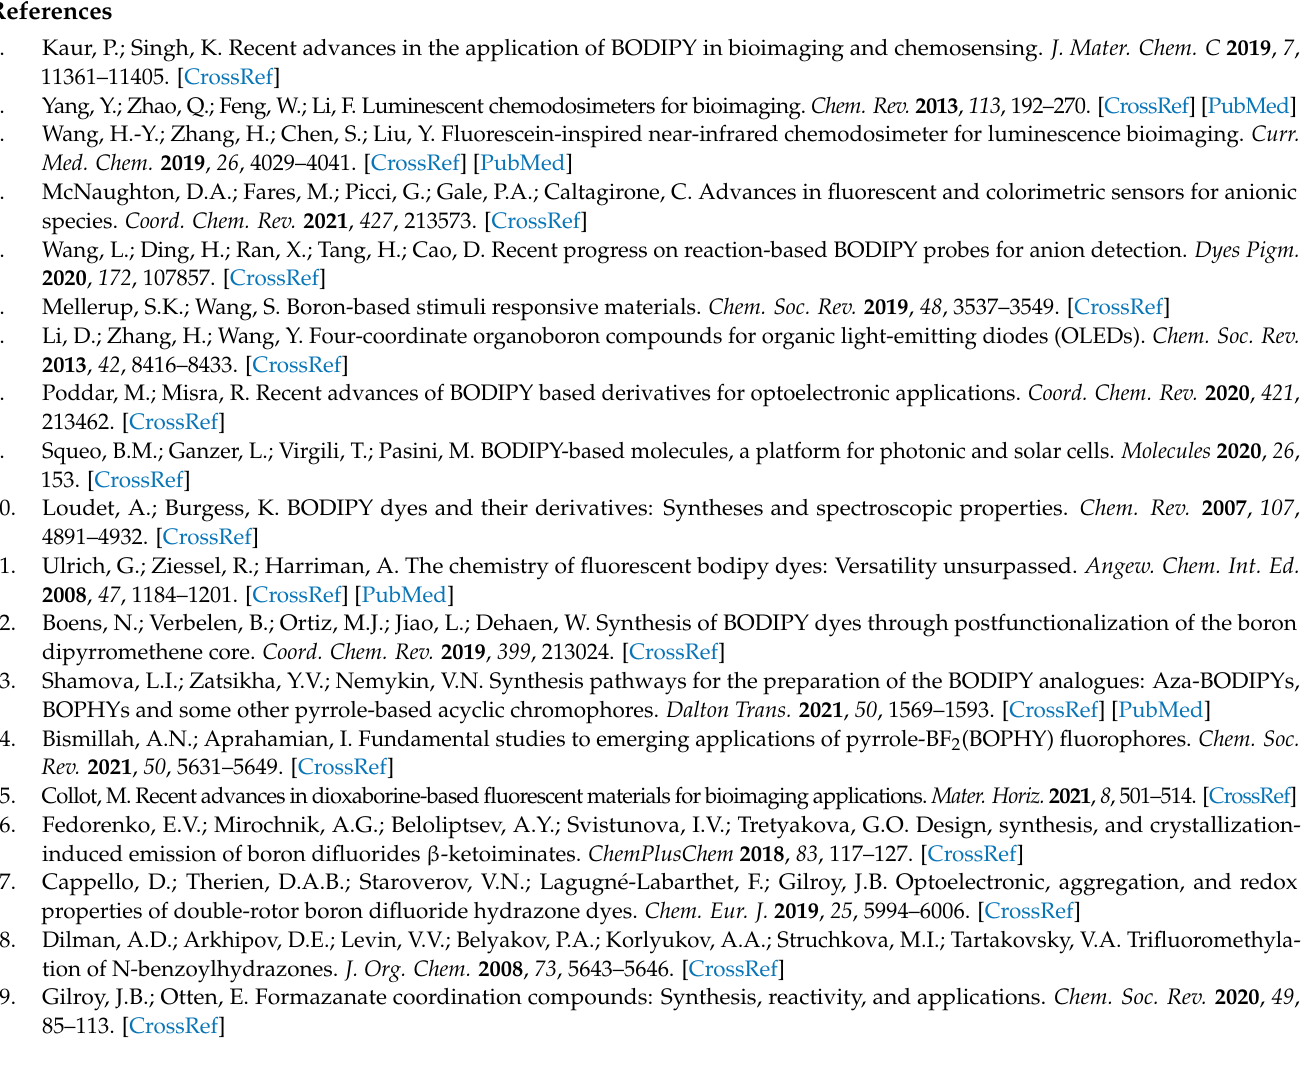
IR-spectrum of 17; Figure S2: 1 H NMR of 17; Figure S3: 13 C NMR of 17; Figure S4: HRMS of 17; Figure S5: IR-spectrum of 18; Figure S6: 1 H NMR of 18; Figure S7: 13 C NMR of 18; Figure S8: 19 F NMR of 18; Figure S9: 11 B NMR of 18; Figure S10: HRMS of 18; Tables S1–S5: Crystal data of